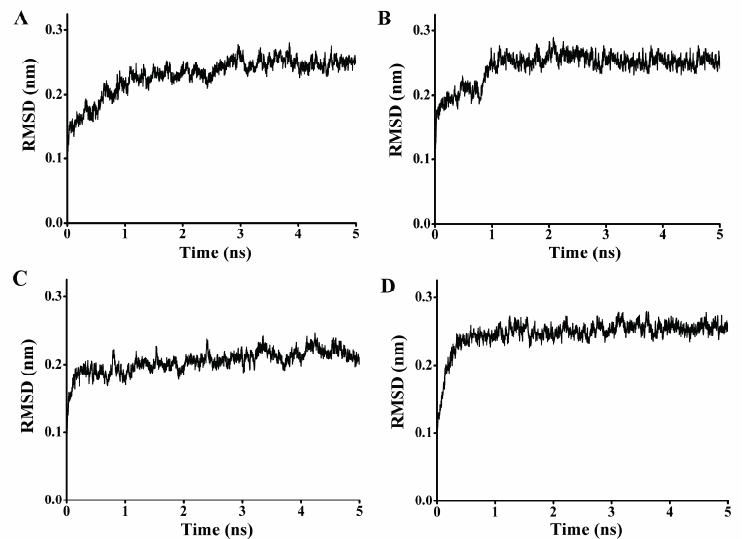
Figure 11. The rmsd values for the backbone atoms of the docked complex during 5 ns simulations. ( A ) The rmsd values for the complex of P186_1588 and p -NPC2; ( B ) The rmsd values for the complex of P186_1588 and p -NPC4; ( C ) The rmsd values for the complex of P186_1588 and p -NPC8; ( D ) The rmsd values for the complex of P186_1588 and p